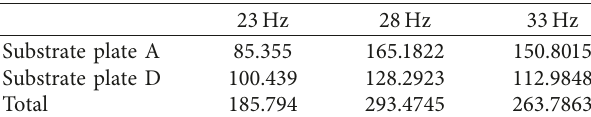
Table 5: Averaged voltage (mV) of the linear EMM system in